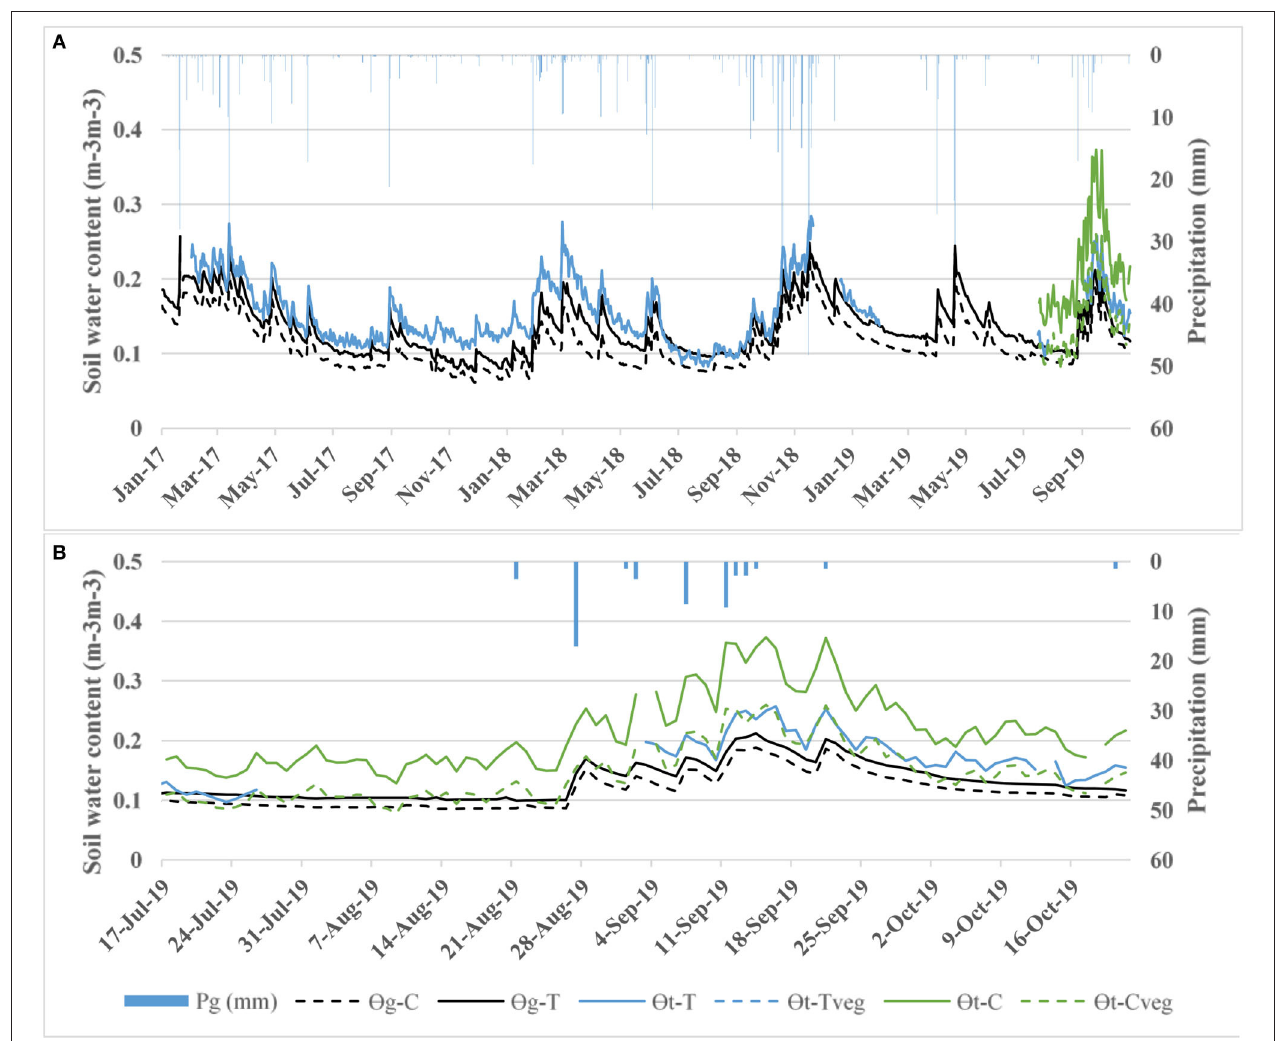
FIGURE 4 | (A) Comparison of soil water content values measured using capacitance probes (O g − T and O g − C ) and CRNP at the T and C plots with the application of the vegetation correction factor f veg (O CRNP − Tfveg and O CRNP − Cfveg ) and without the application of the vegetation correction factor (O CRNP − T and O CRNP − C ). (B) Zoom of date comparison between plots. TABLE 7 | Validation results of both CRNP probes. Plot